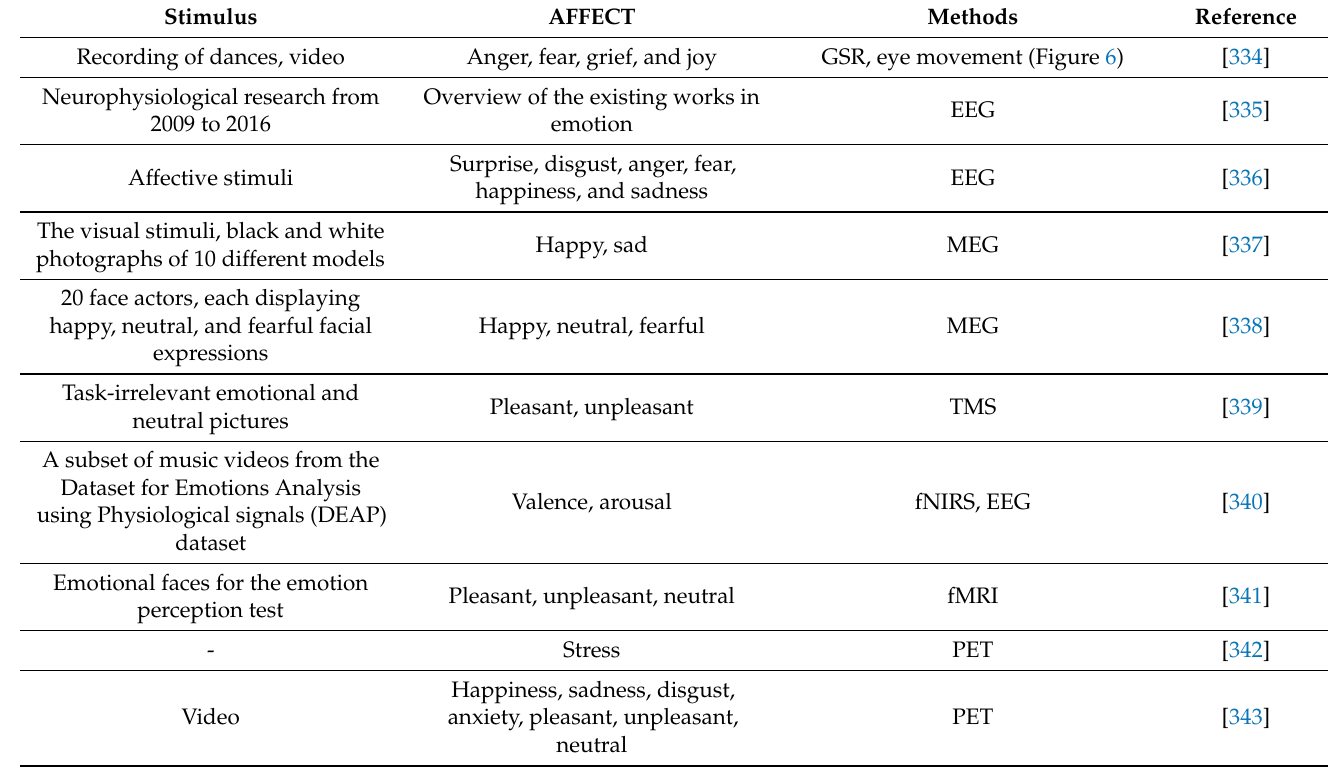
Table 3. An overview of studies on arousal, valence, affective attitudes, and emotional and physio- logical states (AFFECT)